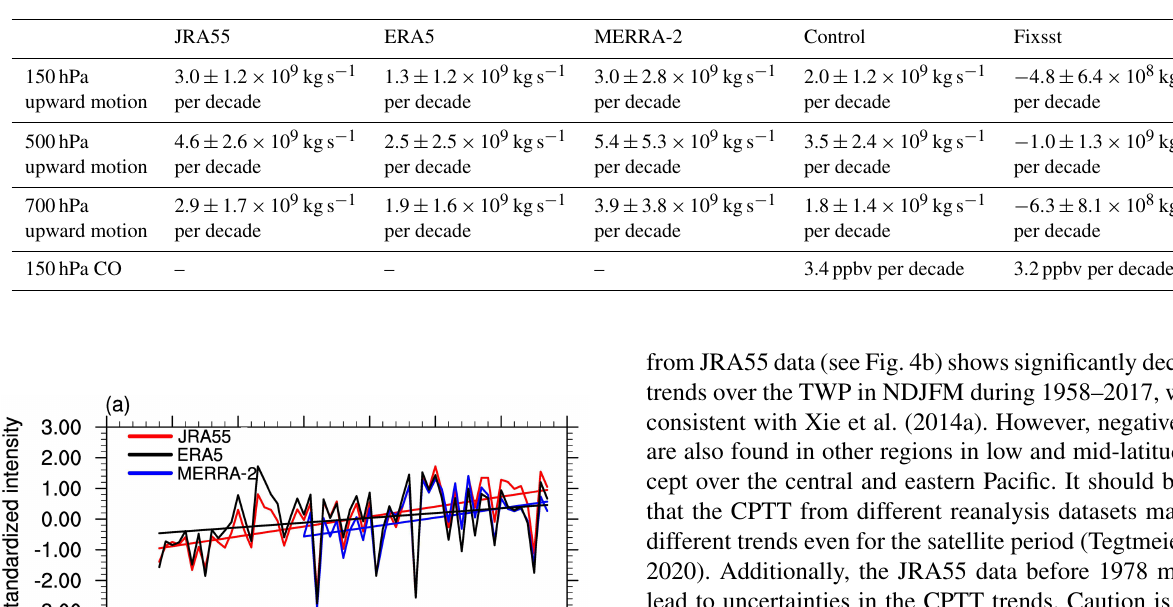
Table 3. The trends of the upward motion over the TWP at 150, 500, and 700hPa in NDJFM during 1958–2017 from JRA55, ERA5, MERRA-2, the Control simulation, and the Fixsst simulation and the trends of 150hPa CO from the Control and Fixsst simulations. Note: ppbv – parts per billion by volume.